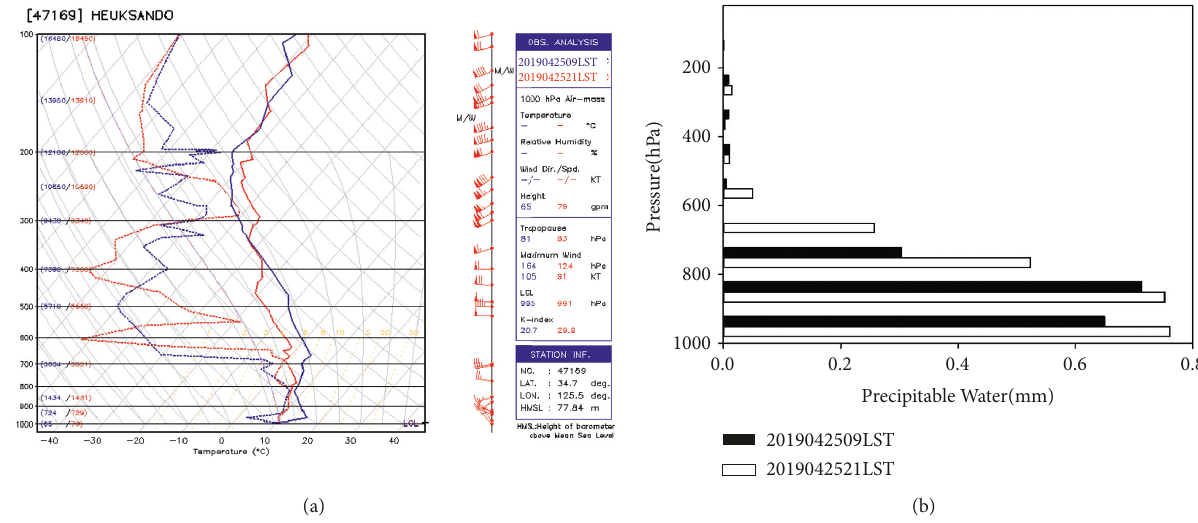
Figure 4: (a) Vertical sounding profile of sounding and (b) precipitable water in Heuksando at 0900 LSTand 2100 LSTon April 25,